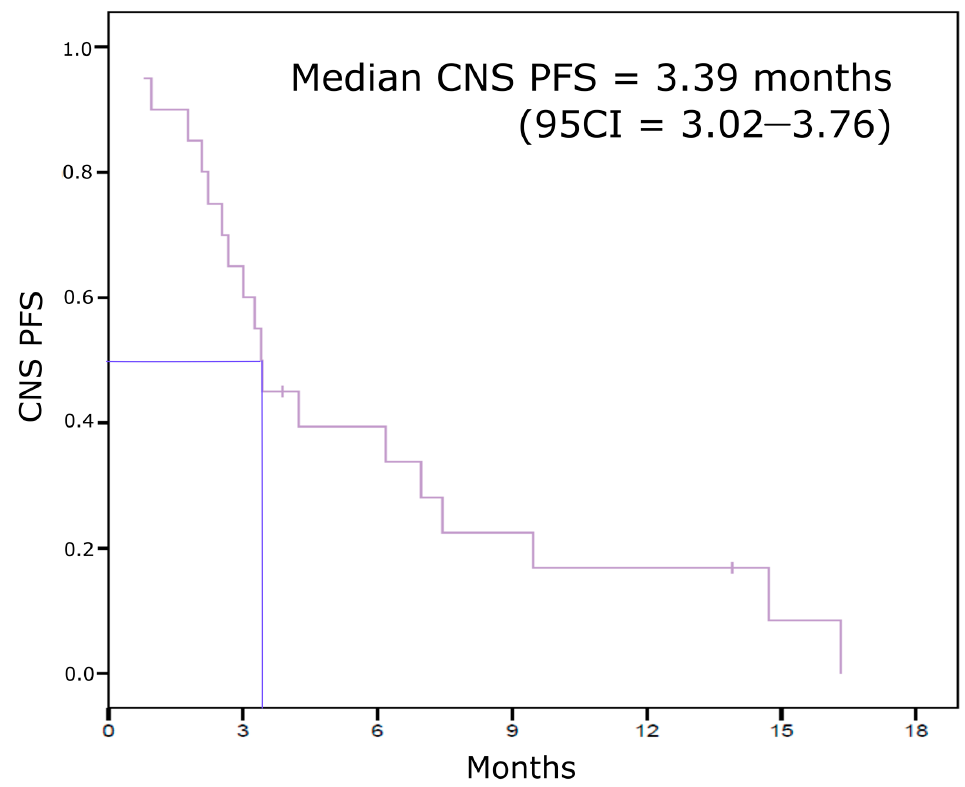
Figure 1. Central nervous system progression-free survival (CNS-PFS) Kaplan–Meier